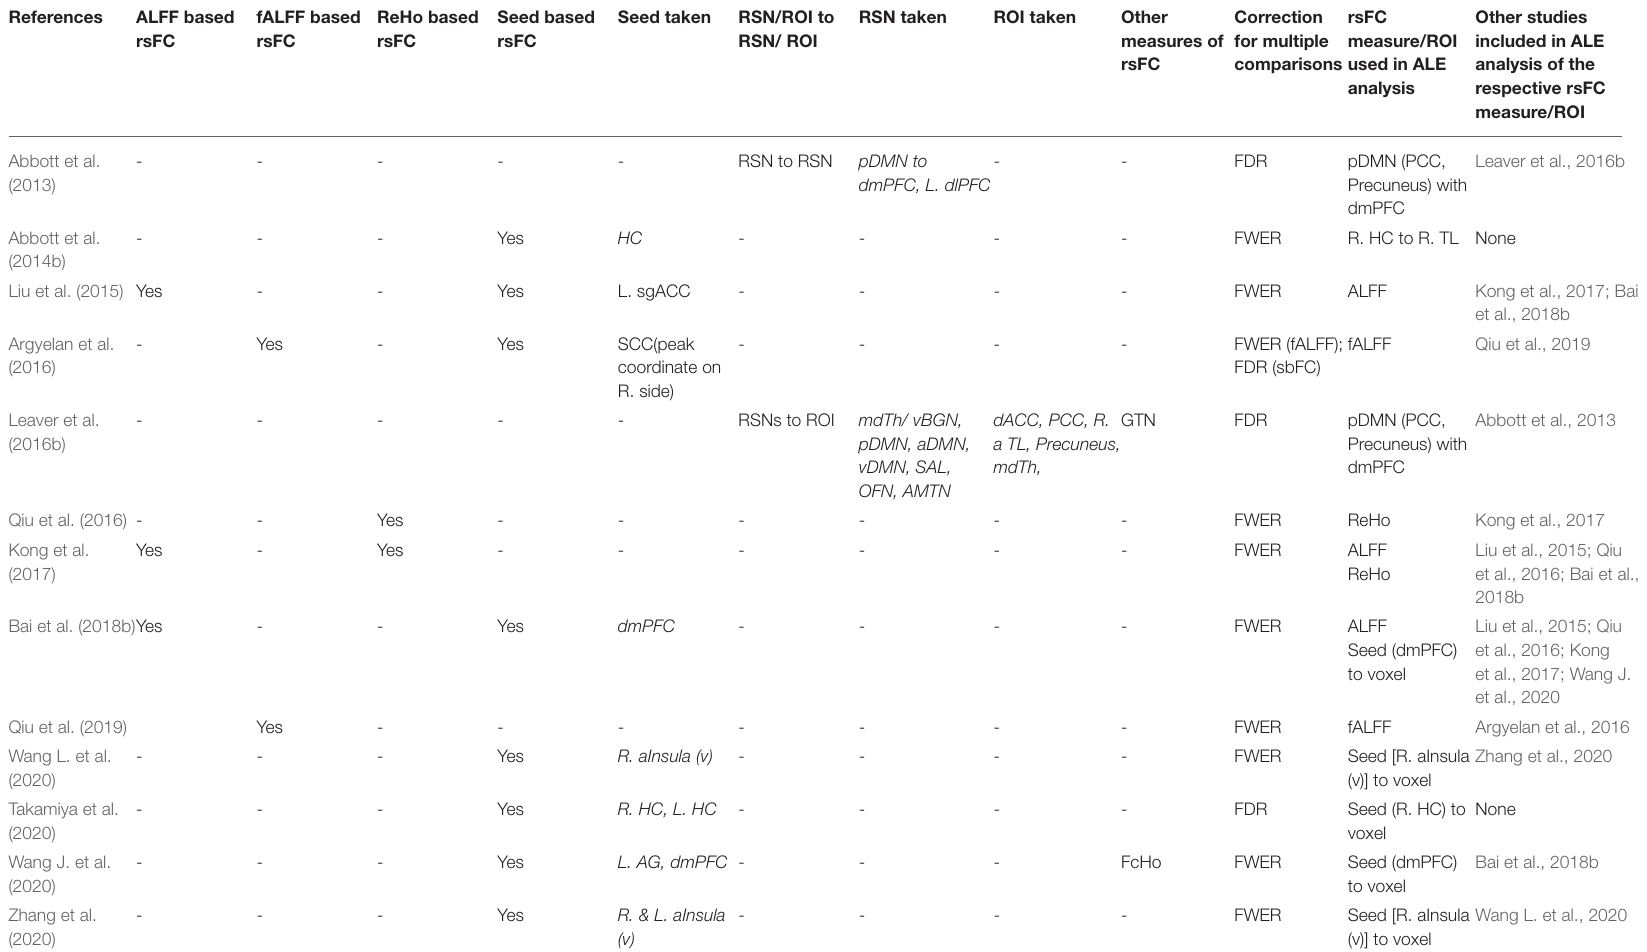
TABLE 1 | List of studies with their different measures of rsFC included in ALE analysis examining the effect of ECT in